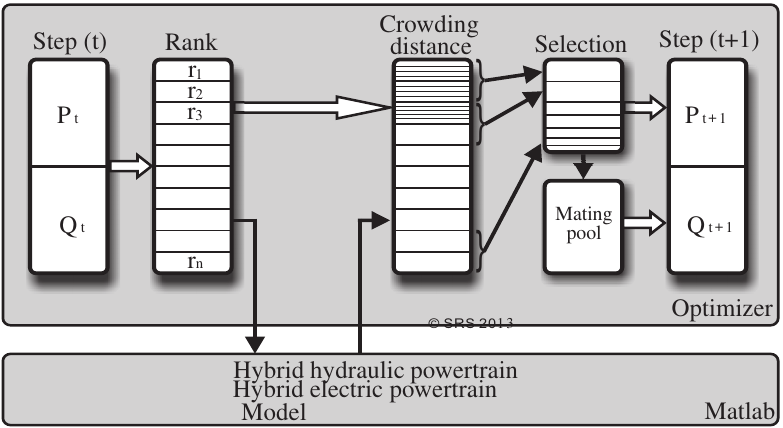
Figure 4. NSGA II-based hybrid powertrain optimization